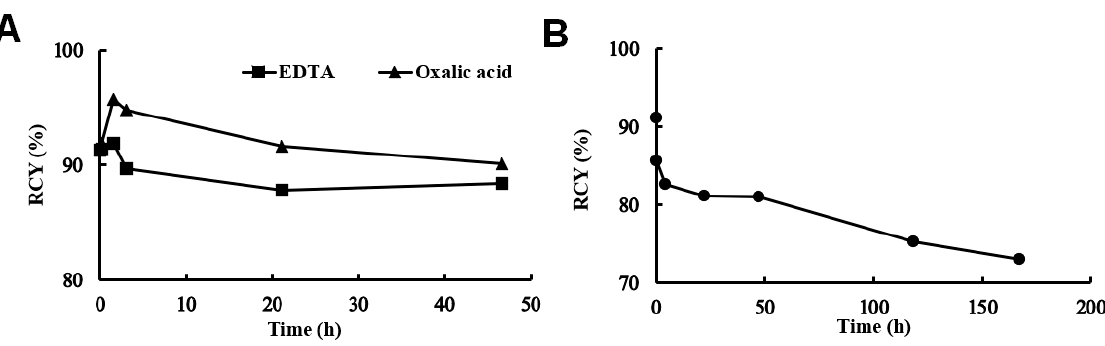
Figure 2. Stability of [ 52 Mn]Mn-DOTAGA-bevacizumab in EDTA and oxalic acid ( A ) and mouse serum ( B ).